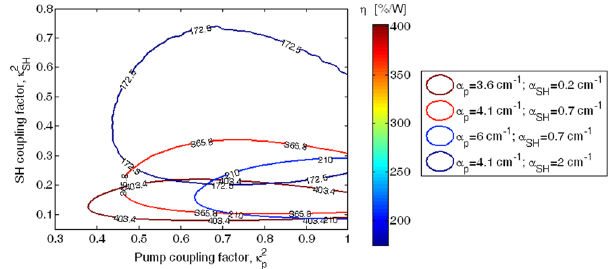
Figure 8. Contour curves at 90% of maximum value of the efficiency η as a function of the pump and SH coupling factor, for different values of pump and SH loss